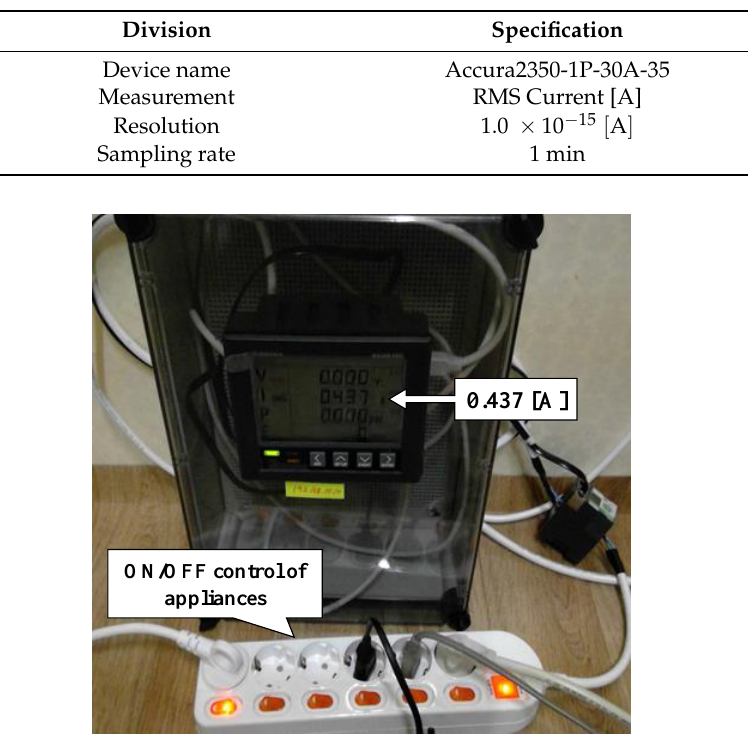
Figure 2. Connection of multi-tap and device for measuring electric current data (relative to whether the appliance was turned on or off) [26].